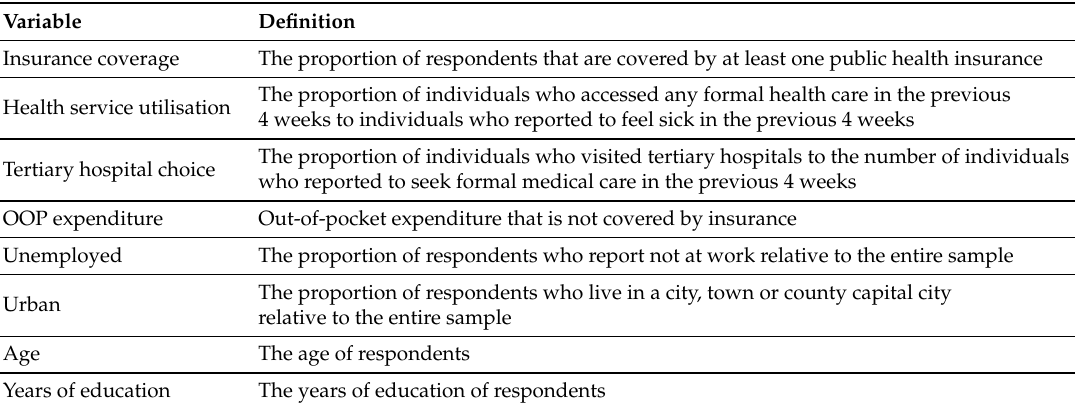
Table 2. Summary of key variable statistics.